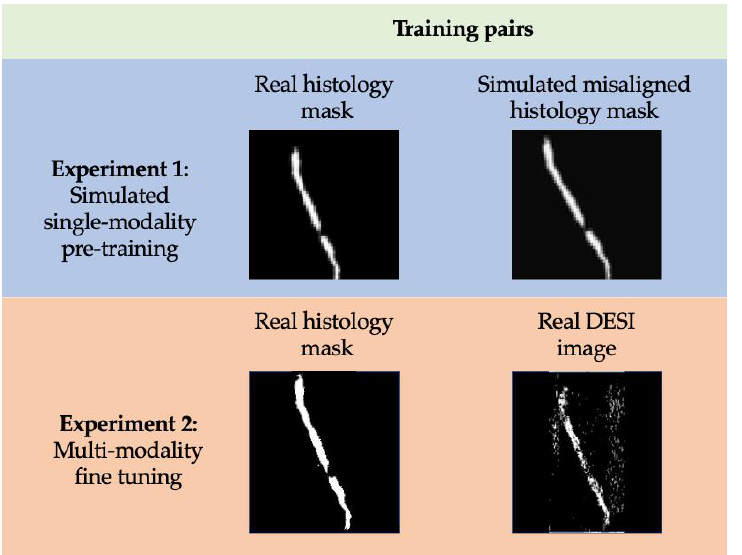
Figure 6. Definition of training pairs used for experiment 1 and experiment 2 of training the first half of the network. In each training pair the simulated or DESI image is considered moving while the real histology mask is considered fixed.